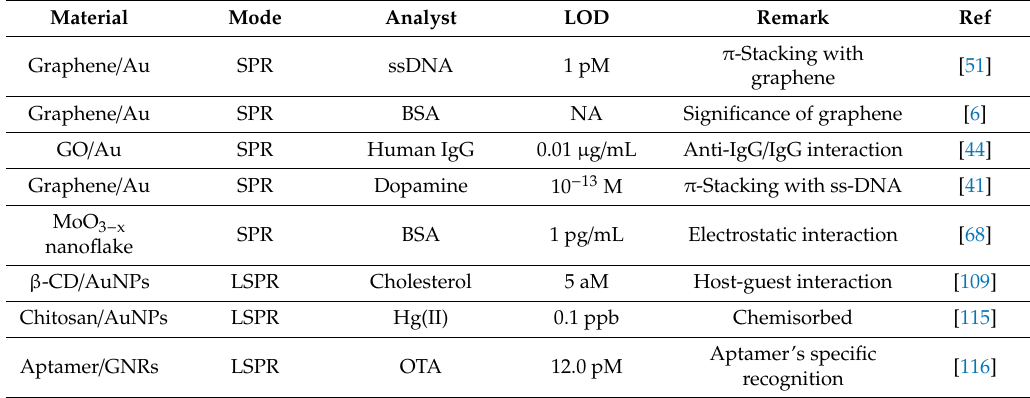
Figure 16. ( a ) The schematic illustration of the fiber-optic LSPR aptasensor. ( b ) Localized magnification of the fiber surface with GNPs immbolized on. ( c ) LSPR shift after ochratoxin A (OTA) recognization (Figure adapted with permission from reference [116]). Table 2. Summary of hybrid fiber-optic sensors in this review.